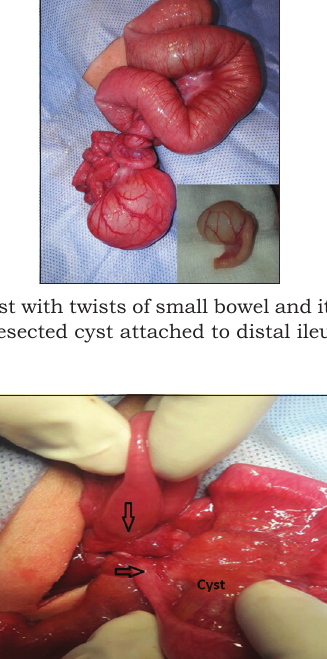
Figure 3: (a) X-ray abdomen. (b) A visible mass in the right abdomen. (c) Duplication cyst intimately attached